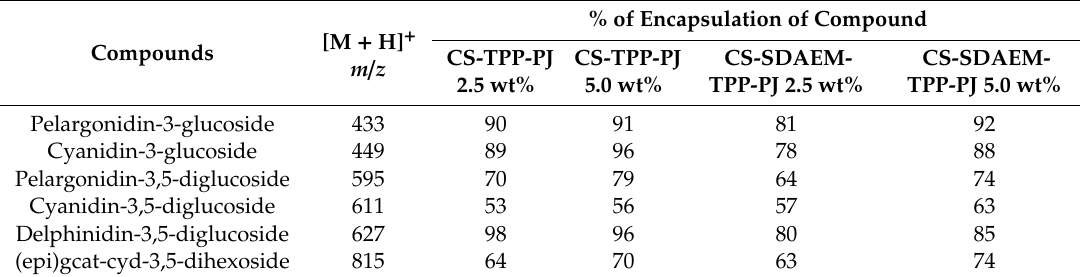
Table 3. Compounds of PJ and their encapsulation e ffi ciency in CS and CS-SDAEM nanoparticles via positive ionization LC / MS [ESI ( + )].